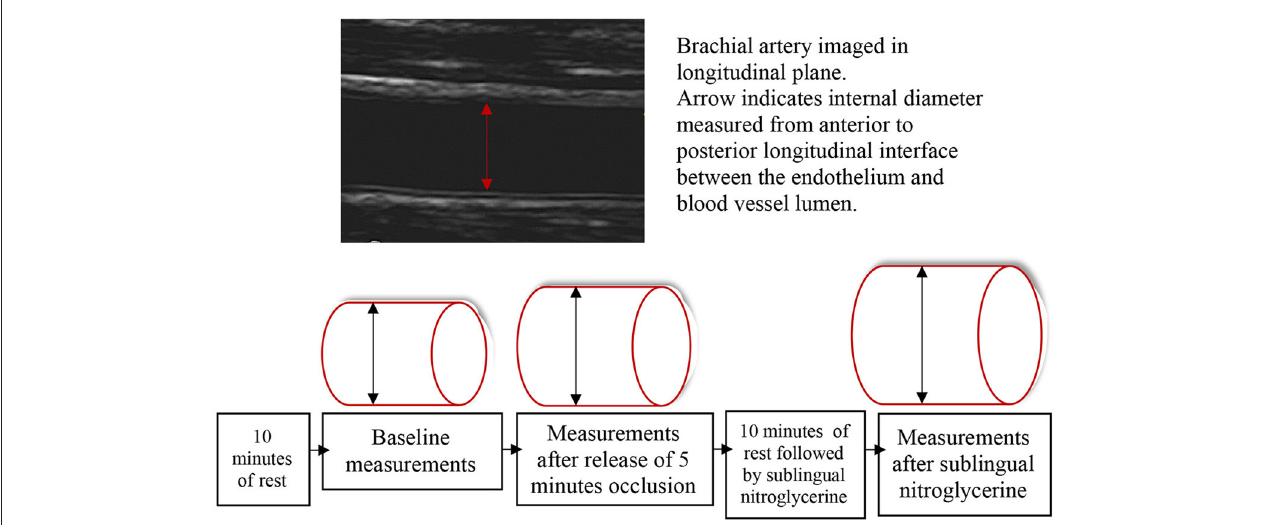
FIGURE 2 | The artery diameter was first measured at baseline after 10min of rest. Thereafter, occlusion of the right brachial artery was done with a blood pressure cuff on the forearm, inflated at least 50 mmHg above systolic blood pressure for 5min. The next measurements were done at peak artery dilatation after release of occlusion. After a second 10-min resting period followed by sublingual nitroglycerine administration, the last measurements were done at peak artery dilatation.